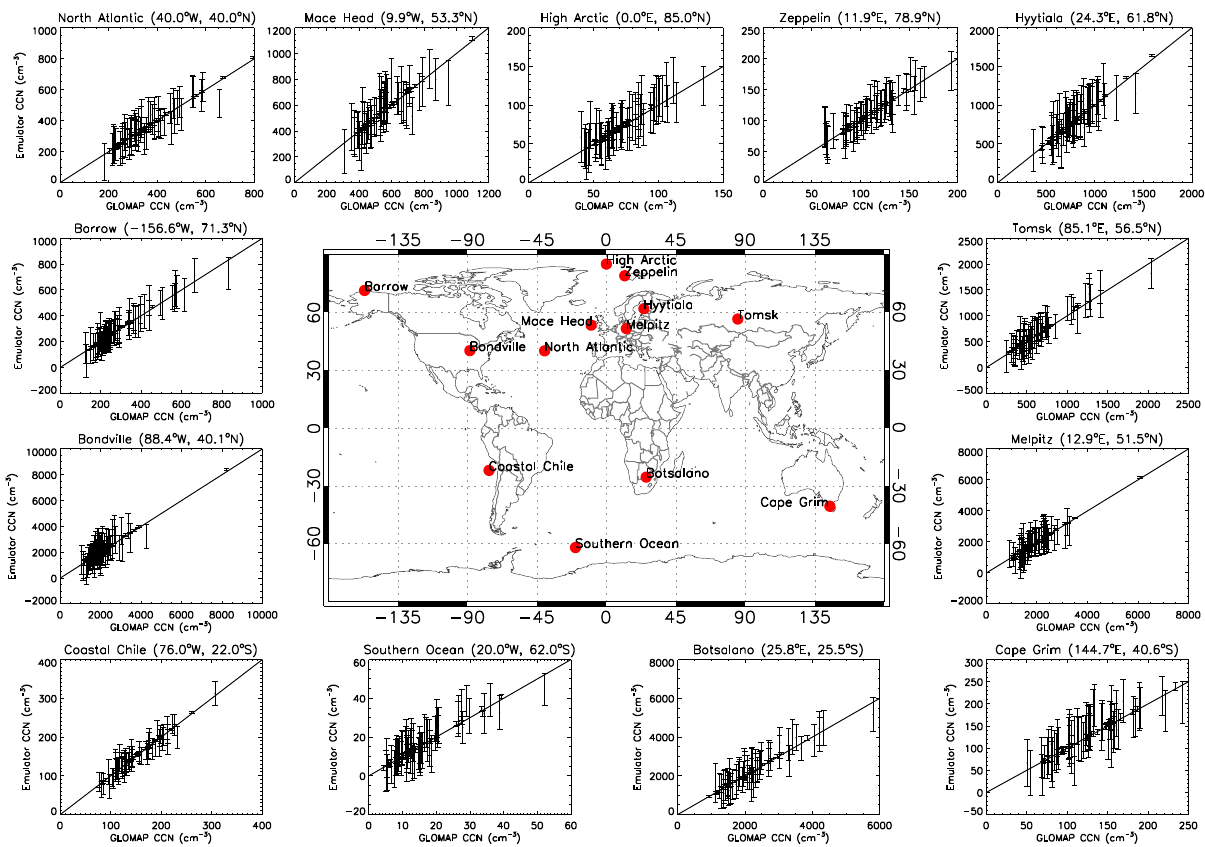
Fig. 3. Grid box validation of emulator-predicted CCN. CCN concentrations predicted by the emulator are compared against CCN from 84 additional GLOMAP model simulations in 13 model grid boxes on the 915hPa model level. The emulator uncertainty is shown as the 95% confidence interval around the emulator estimate calculated from Eqs. (7) and